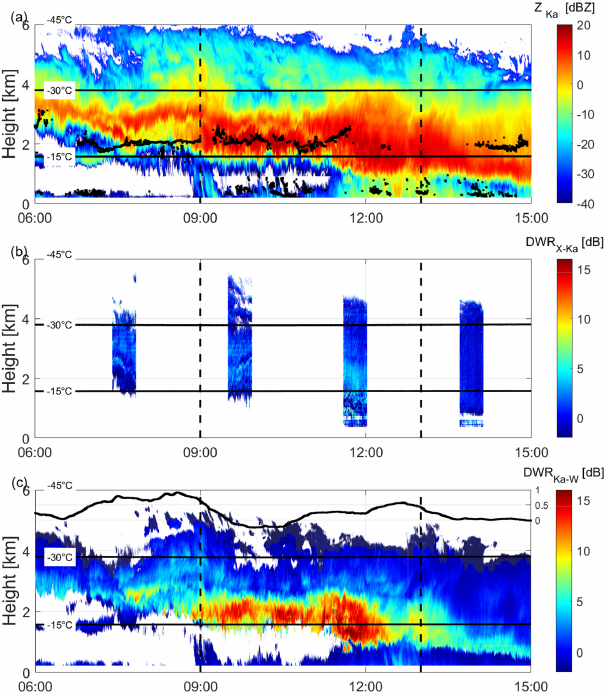
Figure 4. Time–height cross section of the (a) KAZR reflectivity, (b) DWR X , Ka , (c) DWR Ka , W . The horizontal black lines indicate the − 15 and − 30 ◦ C levels while the vertical dashed lines delimit the period of large DWR Ka , W used to produce the density plots in Figs. 7, 8 and 9. The black dots in (a) show the liquid water as de- tected by the ARM high spectral resolution lidar (HSRL) cloud base height product (Silber et al., 2018b; see also the inset in Fig. 13a). The thick black curve in the upper part of (c) is the two-way (cid:49) PIA in dB (scale along the right axis) derived from Rayleigh scattering hydrometeors at cloud top (gray-shaded zones) following Tridon et al. (2020).